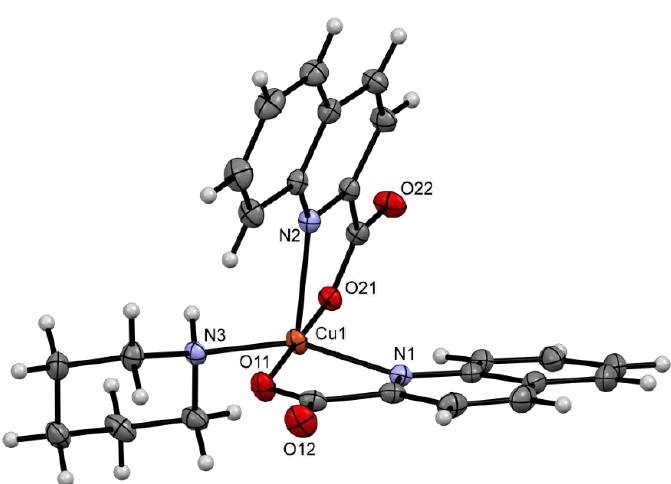
Figure 6. ORTEP drawing of [Cu(quin) 2 (pipe)], a complex molecule of 6 . Displacement ellipsoids are drawn at the 50% probability level. Hydrogen atoms are shown as spheres of arbitrary radii.